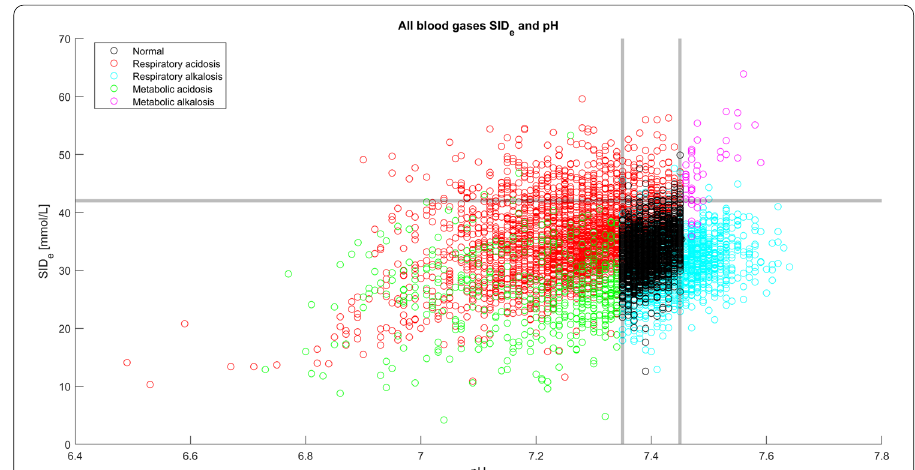
Fig. 5 SID e (estimated) did not correlate with pH in the cohort. SID e did not either correlate with pH for exclusively metabolic acidoses (green) nor for metabolic alkaloses (purple). Blood gases with normal pH are shown in